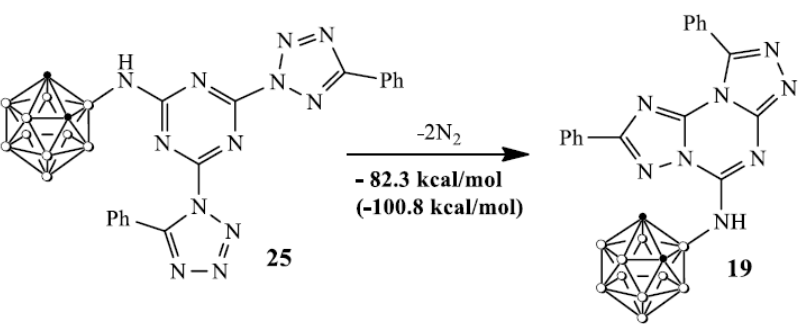
Figure 1 Figure 1. Values of enthalpy and a change in the Gibbs free energy in the process of transformation of 25 into 19